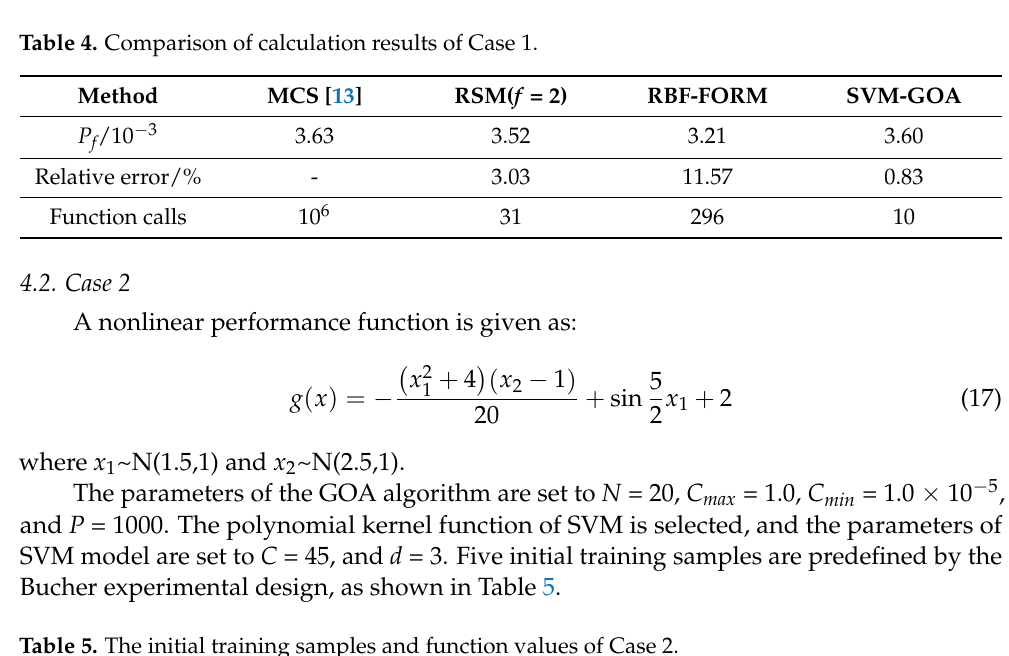
Table 5. The initial training samples and function values of Case